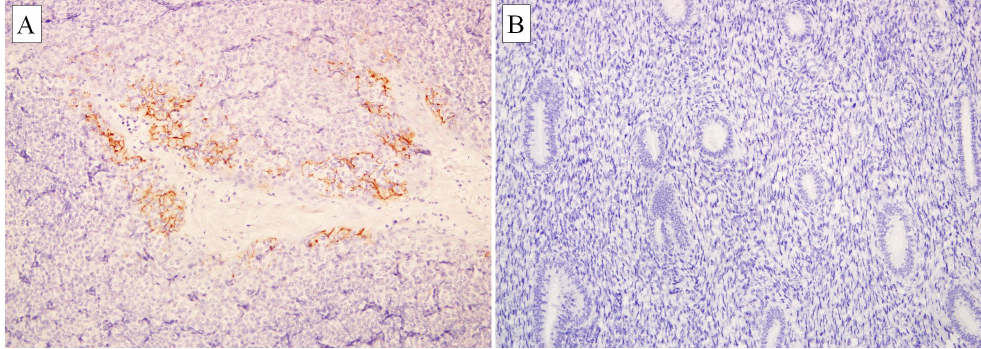
Figure 1. PD-L1 immunohistochemistry showed membranous staining. ( A ) Strong PD-L1 staining in